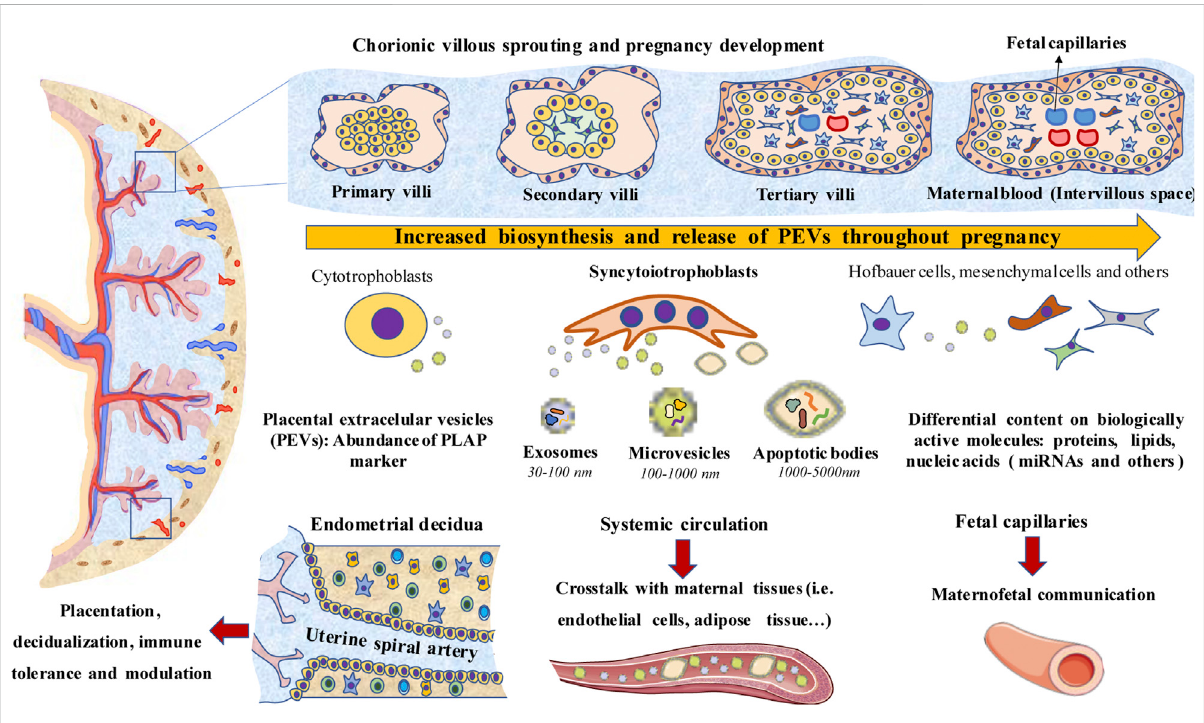
FIGURE 1 A general overview of PEVs. Biosynthesis and release of PEVs increase as pregnancy progresses along with the development of the placental structures.Syncytiotrophoblasts,whichareincontactwithmaternalblood(Intervillousspace),areamajorsourceofPEVs,althoughcytotrophoblast, Hofbauercells,mesenchymalcells,extravilloustrophoblastsandothersalsoproducethem.PEVsareessentialfortheinterplaybetweentheplacenta and endometrial decidua, modulating both the placentation and decidualization processes. PEVs also modulate the immune system, the in fl ammatory response and immune tolerance. PEVs reach systemic circulation or enter through fetal capillaries into the fetal circulation, playing a key role in the crosstalk between the placenta with maternal and fetal